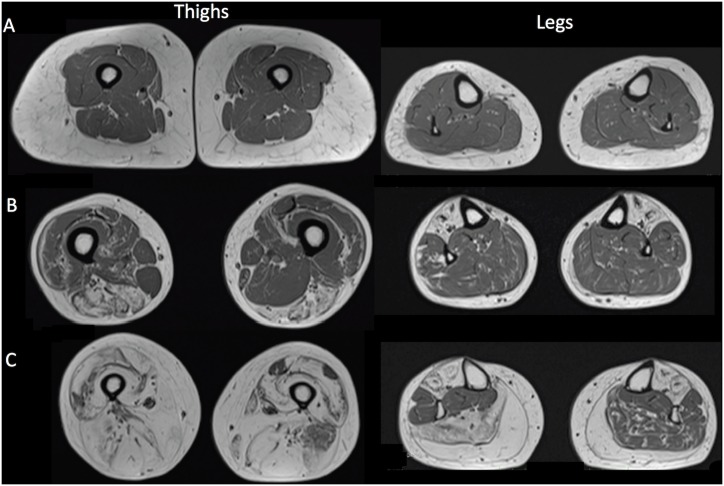
T1 weighted MRI images of thighs and legs from 3 FSHD1 patients illustrating three different patterns of muscular involvement.(a): a normal appearing imaging pattern, (b): a selective muscle involvement pattern; (c): global fatty infiltration pattern with selective muscle sparing